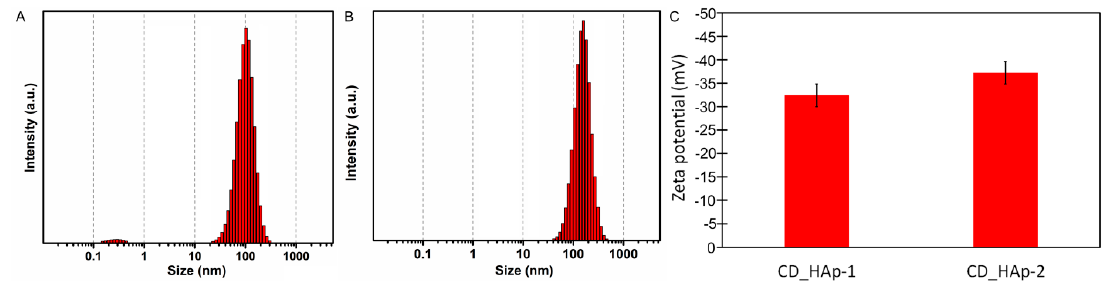
Figure 1. Particle size distribution measured by DLS of: CD-HAp_1 ( A ); and CD-HAp_2 ( B ) nanoparticles suspensions. Zeta potential of CD-HAp_1 and CD-HAp_2 nanoparticles suspensions ( C ).